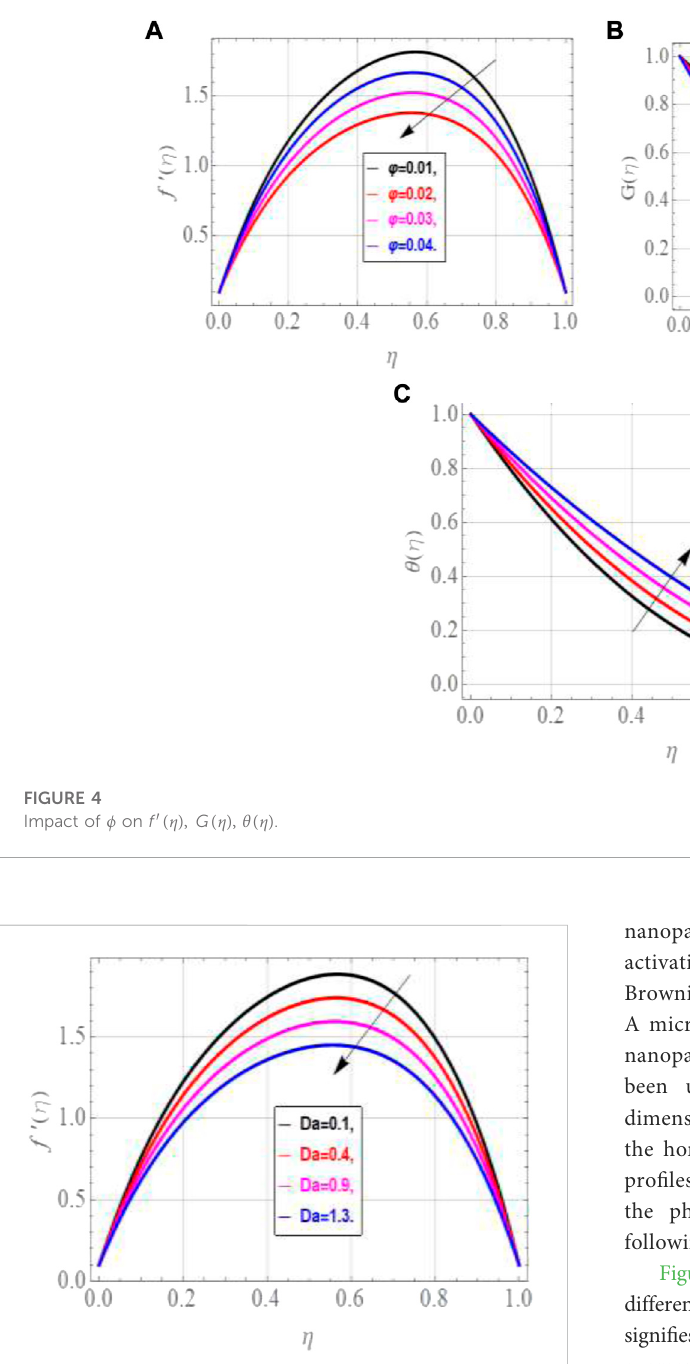
FIGURE 5 Impact of Da on f ′ ( η )